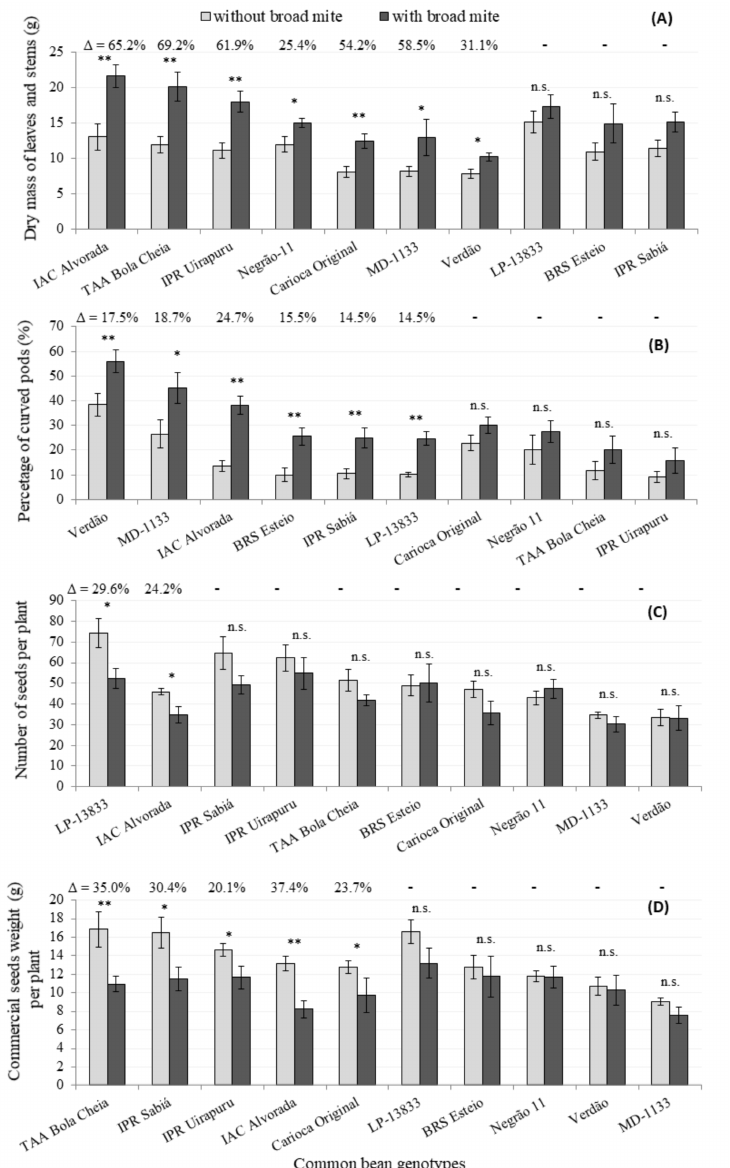
Figure 4. Dry mass of the leaves and stems ( A ), percent of curved pods ( B ), number of commercial seeds ( C ) and commercial weight of seeds per plant ( D ) of genotypes of common bean infested (dark column) and non infested (clear column) with Polyphagotarsonemus latus . Single (*) and double (**) asterisks over bars indicate significant at 5% and 1%, respectively, by Student t test, while n.s. indicates not significant. ∆ values indicate the increment when infested vs. non infested plants were